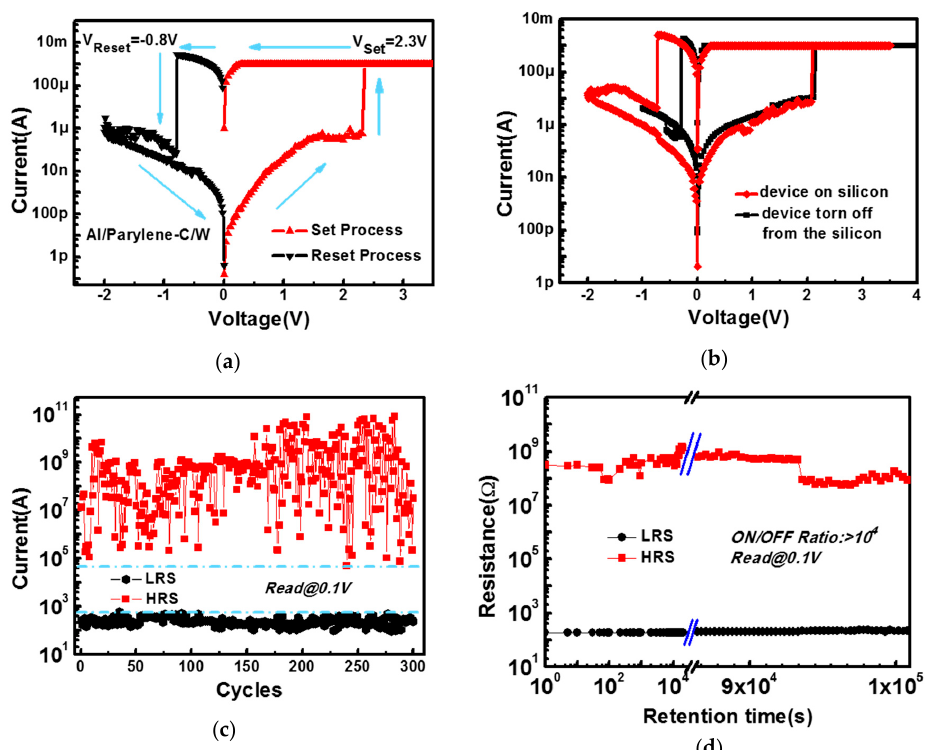
Figure 2. ( a ) Measured typical I-V curves of the Al/polychloro-para-xylylene (parylene-C)/W device; the arrows show the direction of voltage sweep; ( b ) The I-V characteristics of the fabricated device. The red diamonds show the I-V curve of the device fabricated on the silicon wafer, and the black squares show the I-V curve after the device was torn off from the silicon wafer; ( c ) Measured endurance characteristics of the polymer device by the direct-current (DC) sweep operation; ( d ) Retention behavior of the polymer device measured by applying a 0.1 V read voltage.